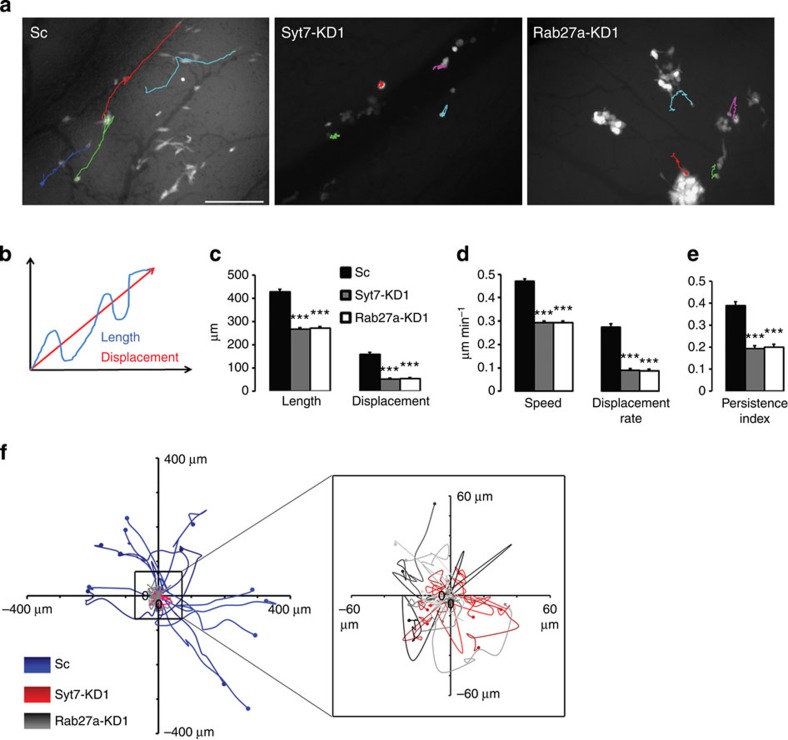
Endolysosomal secretion is critical for persistent and fast migration(a) Representative images of HT1080 cells migrating within the CAM. Representative cell tracks are shown. Scale bar, 200 μm. See also Supplementary Movies 1 and 2. (b) Depiction of total path length (Length, blue curved line) and productive migration (Displacement, red arrow) calculations from cell tracks. (c) Length and displacement plots. (d) Speed, calculated by length divided by time. Displacement rate, calculated by displacement divided by time. (e) Persistence index, calculated as displacement rate divided by speed. (f) Wind–Rose plots from cell tracks. Magnification of boxed area shown on right. Error bars, s.e.m. from four independent experiments (n>130 cells for each cell line). ***P<0.001 compared with Sc by Student's t-test.